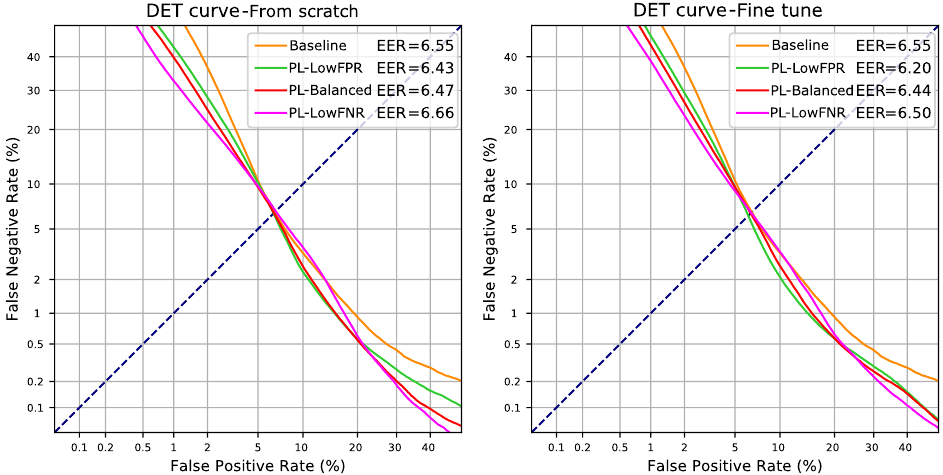
Figure 5. DET curve and EER (%) on the FS02 development partition using the pseudo-label domain transfer setup training a new neural network from scratch ( left ) and fine-tuning the baseline neural network ( right ), both compared to the baseline system.